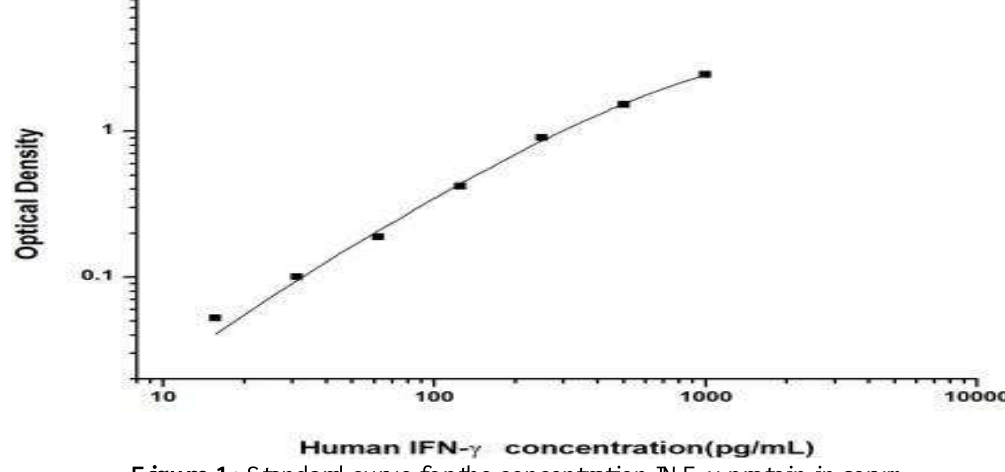
Figure 1: Standard curve for the concentration INF-y protein in serum.